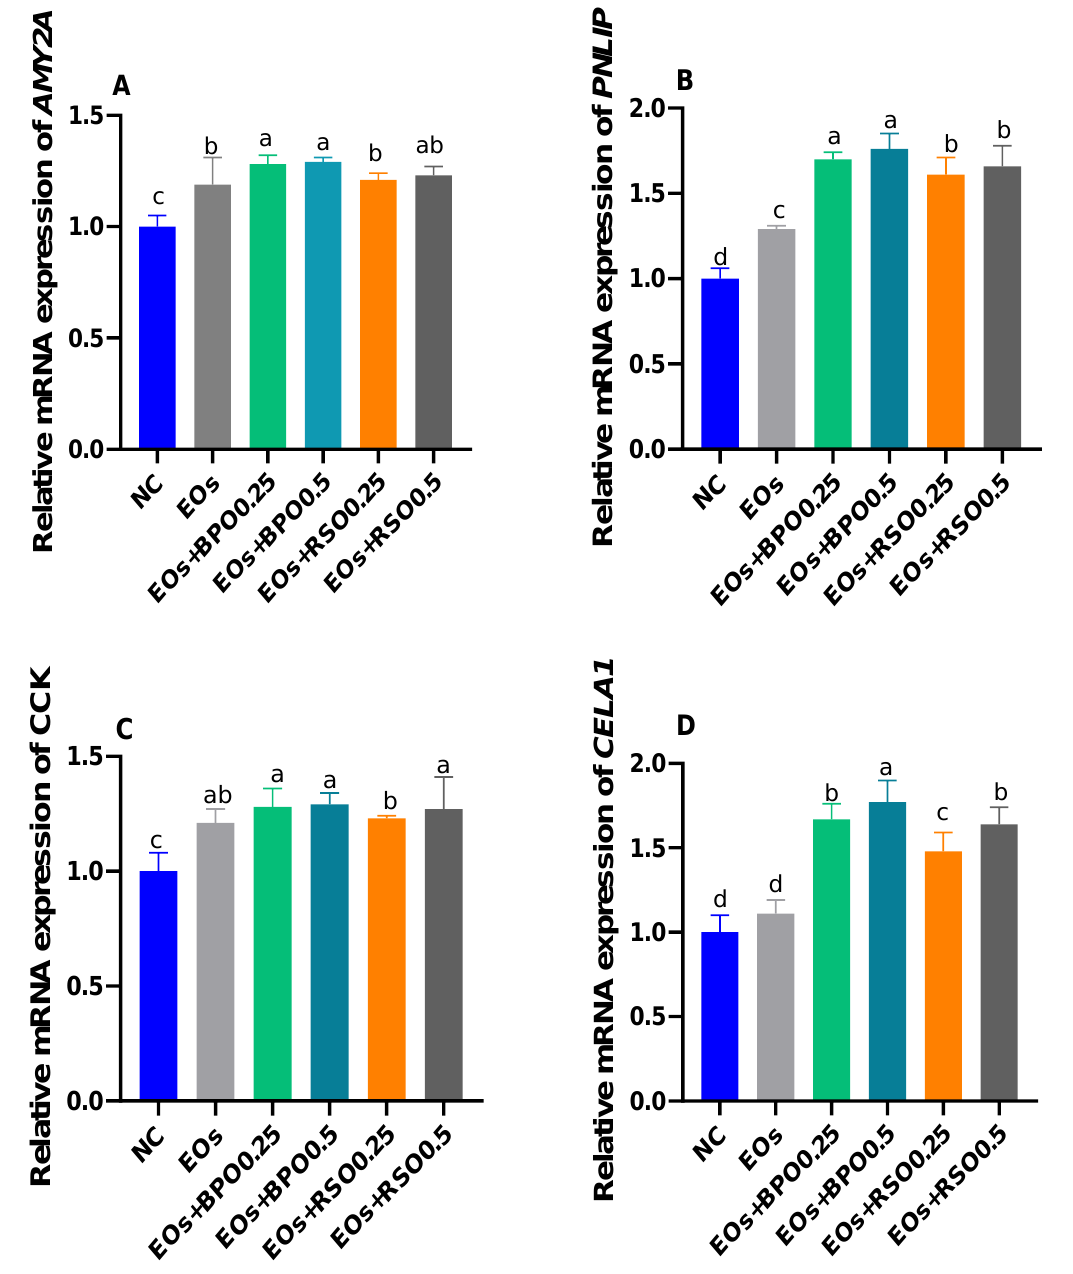
Figure 1. Effect of EOs with black pepper oil or radish seeds oil on mRNA expression of digestive enzymes related genes (pancreatic alpha 2A amylase (AMY2A, ( A ), pancreatic lipase ( PNLIP , ( B )), cholecystokinin ( CCK , ( C )) and chymotrypsin-like elastase family, member 1 (CELA1, ( D )); abcd means within the same column carrying different superscripts are significantly different at ( p < 0.05). EOs mixture of mint, parsley, and carrot oils. NC: feed basal diet without additives; EOs: birds fed a basal diet supplemented with 1.5 g/kg EOs; EOs + BPO0.25: birds fed a basal diet supplemented with 1.5 g/kg EOs plus 0.25 g/kg black pepper oil (BPO); EOs + BPO0.5: birds fed a basal diet supplemented with 1.5 g/kg EOs plus 0.25 g/kg black pepper oil (BPO); EOs + RSO0.25: birds fed a basal diet supplemented with 1.5 g/kg EOs plus 0.25 g/kg radish seed oil (RSO); EOs + RSO0.5: birds fed a basal diet supplemented with 1.5 g/kg EOs plus 0.5 g/kg radish seed oil (RSO).